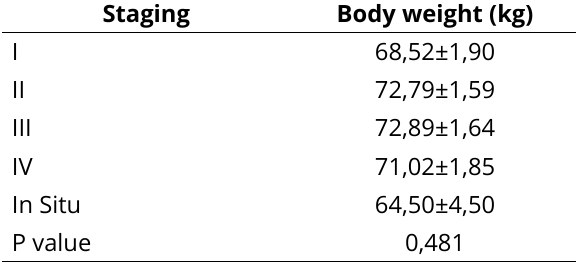
Table 3. Result of the comparison between different staging of the disease, in relation to the body weight of the